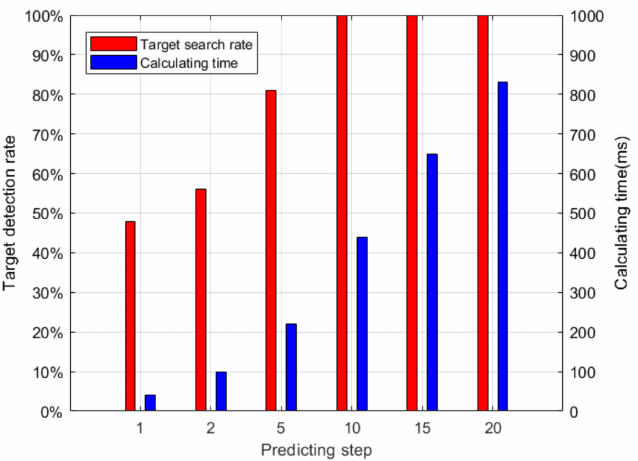
Figure 15. The influence of different prediction steps on the performance of the